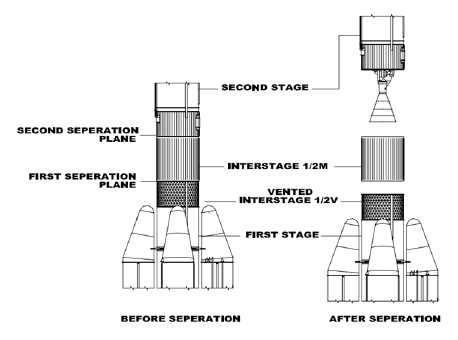
Figure 1. Schematic diagram of rocket’s inter-stage separation system [1].